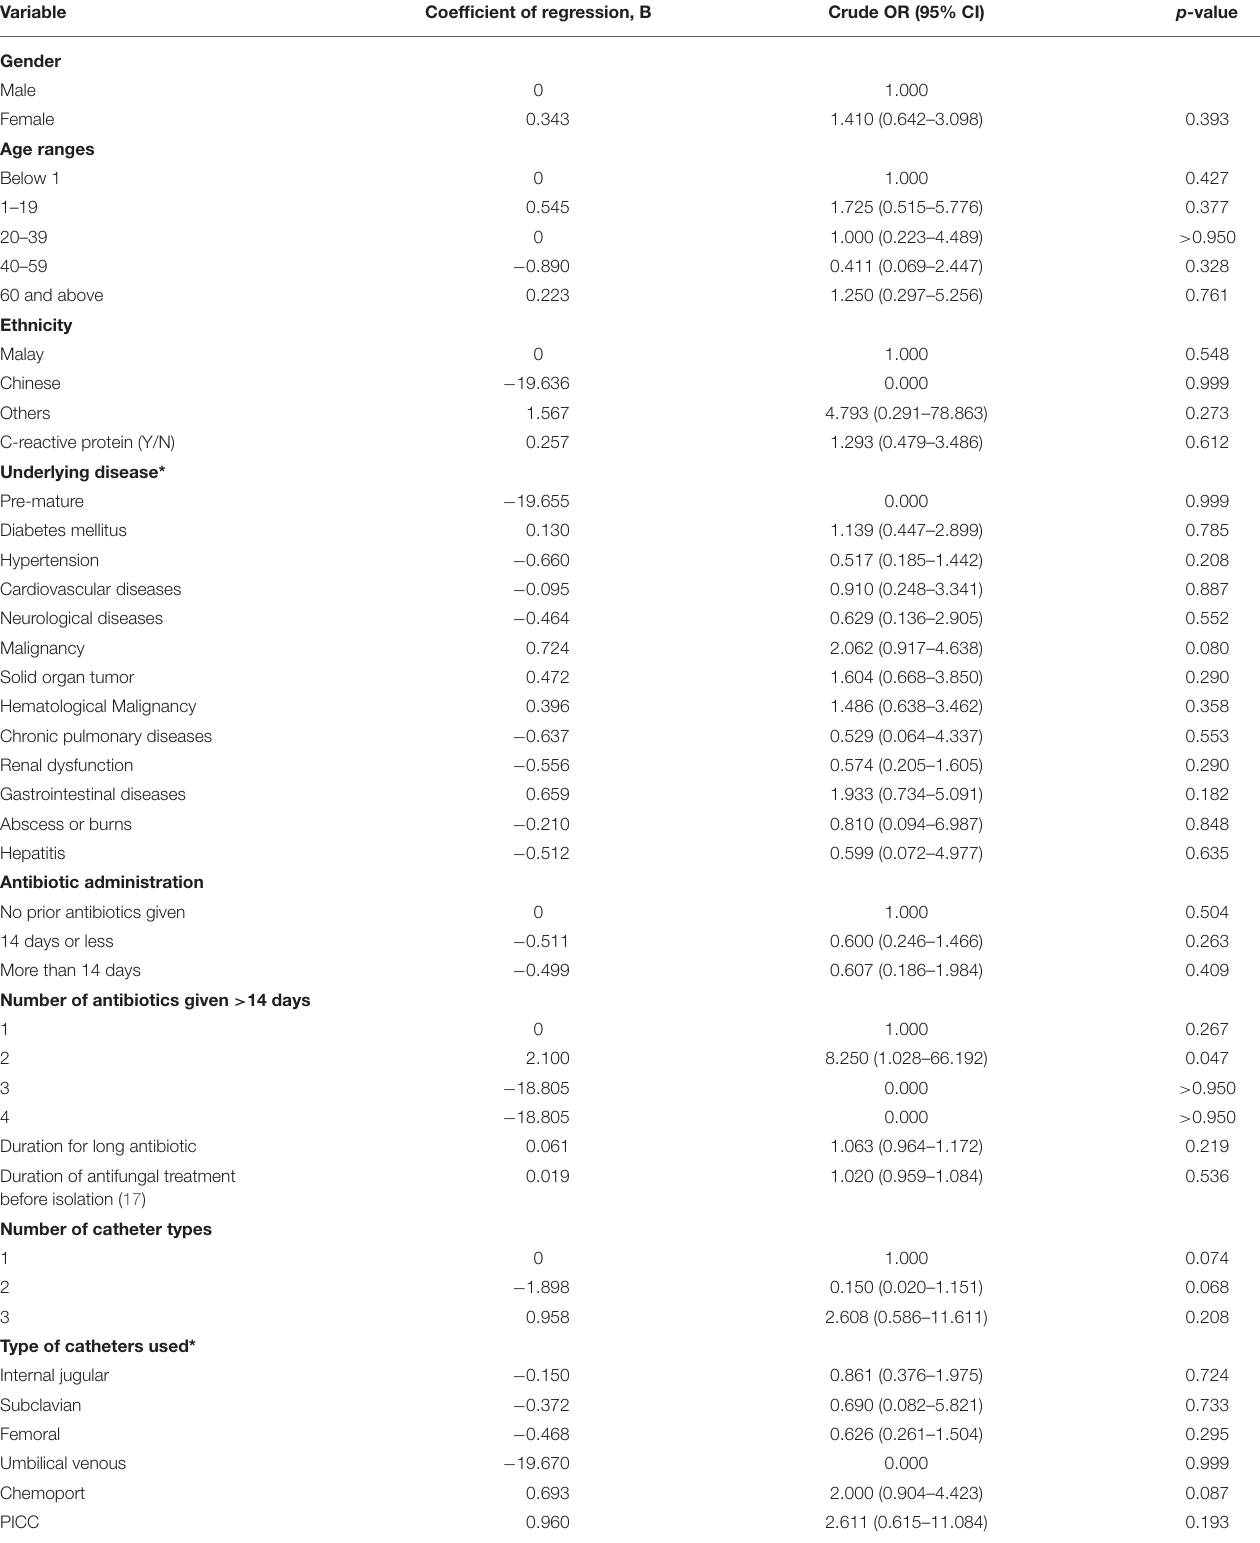
TABLE 3 | Univariate analysis of C. parapsilosis CRBSI risk factors.